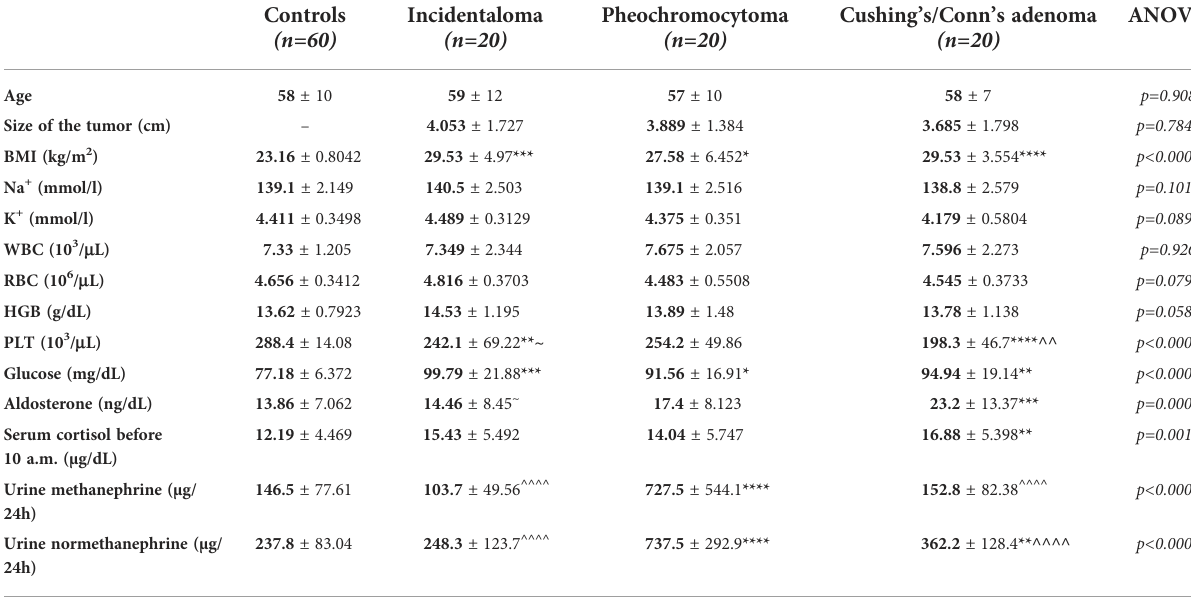
TABLE 1 Clinical and routine laboratory characteristics of the controls, incidentaloma, pheochromocytoma, and Cushing ’ s/Conn ’ s adenoma